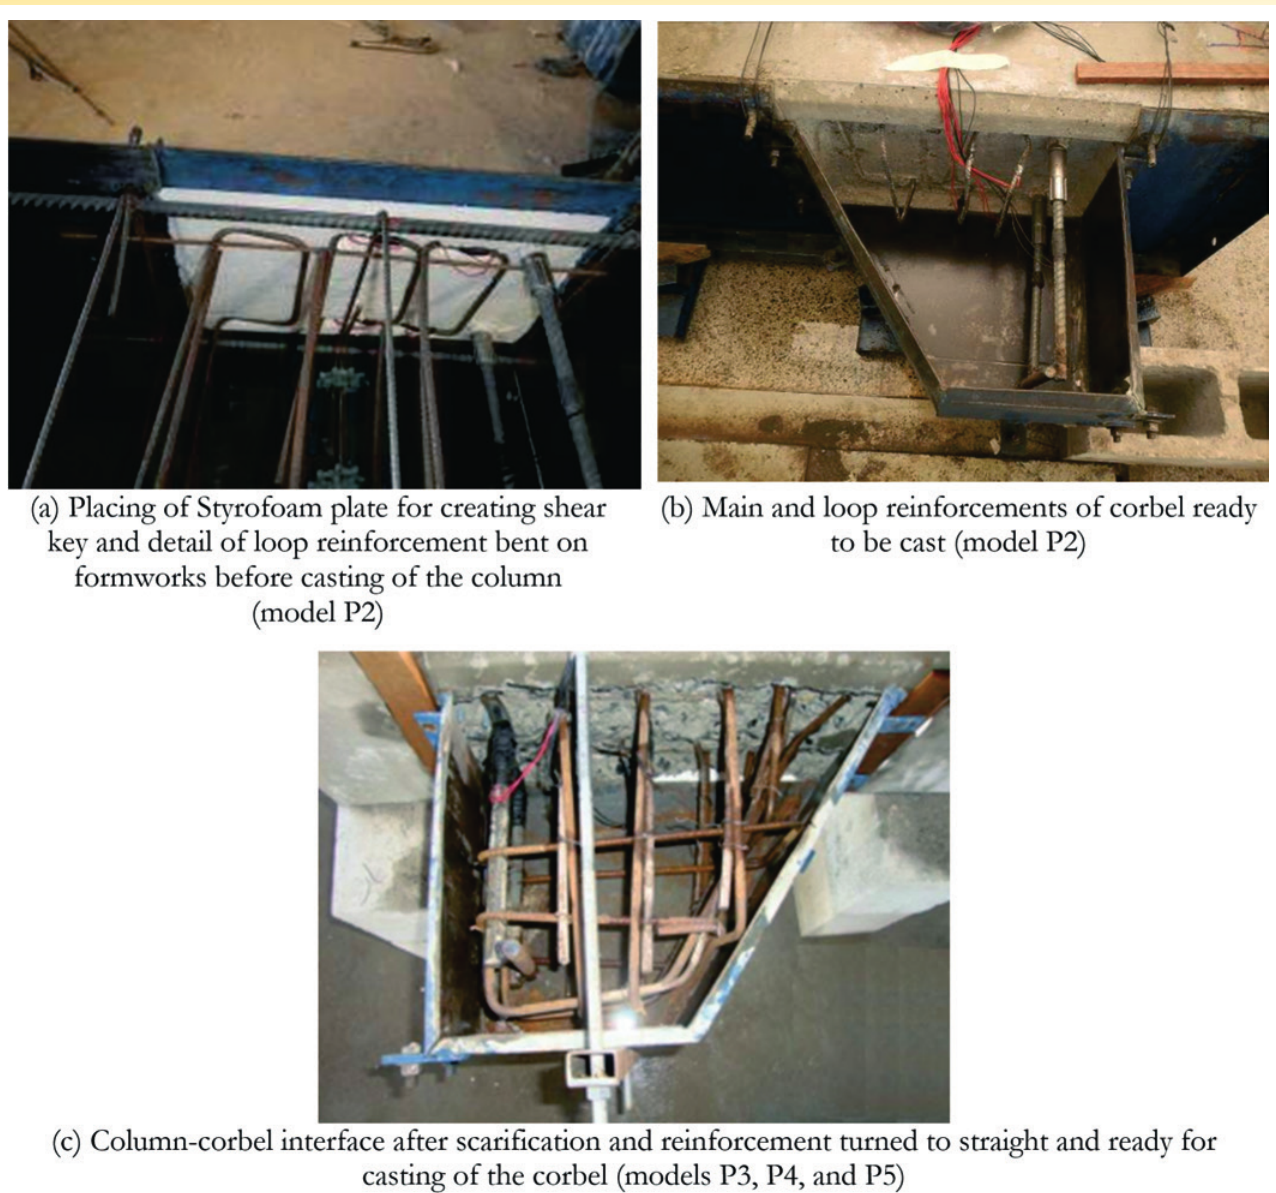
Treatment of the interface and reinforcements of models cast in different stages – P2, P3, P4, and